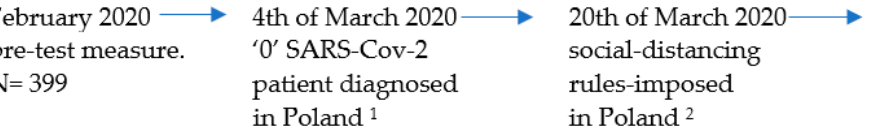
Figure 1. Study design with critical time frames. 1 Puls Medycyny, Pierwszy, potwierdzony przypadek COVID-19 w